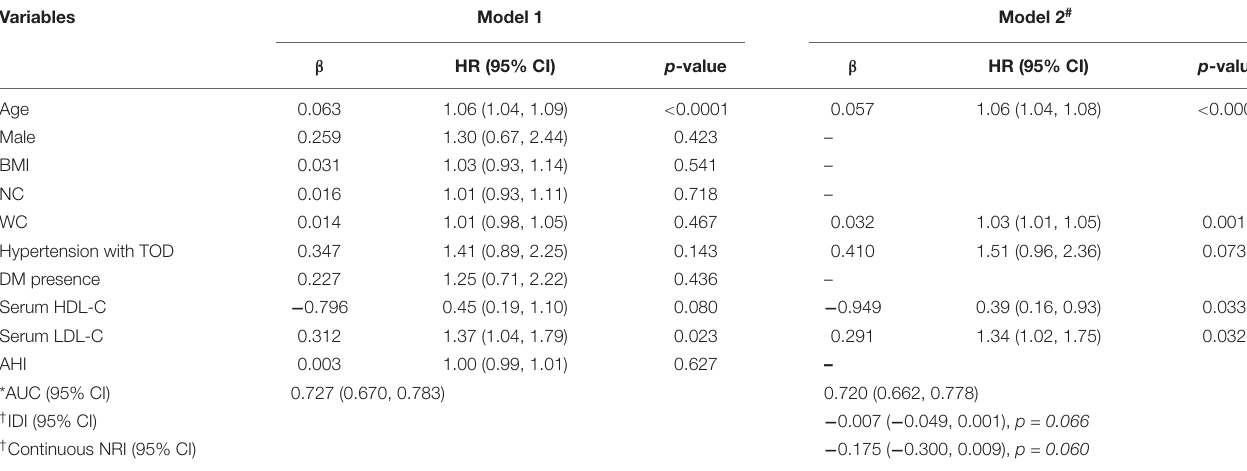
TABLE 3 | Multivariate cox regression analysis to construct a nomogram model from randomly grouped data for prediction CHD in the training set.